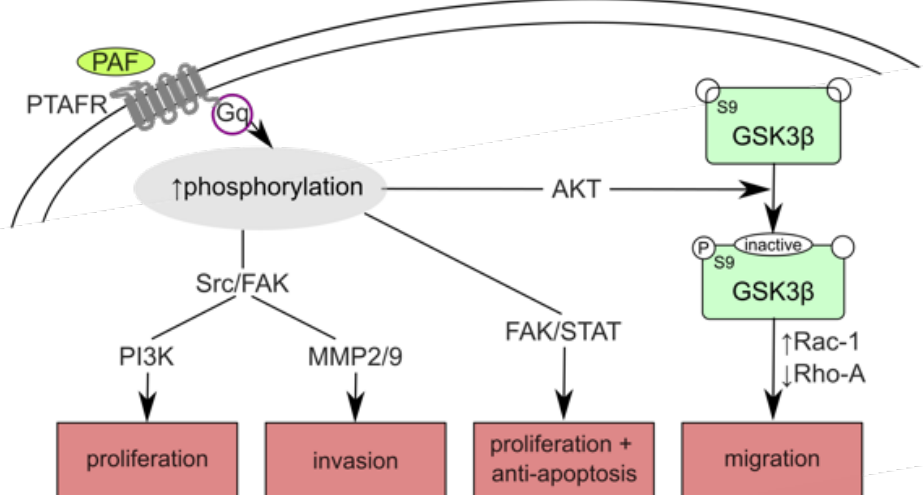
Figure 8. Functional consequences of PAF-AH silencing. By PLA2G7 silencing, PAF-mediated signaling dominated. Binding to its Gq-coupled receptor PTAFR, PAF activated phosphorylation cascades, which often lead to oncogenic transformation, tumor growth, angiogenesis, and metastasis [15,53,60,61]. Activation of Src/FAK and their downstream targets PI3K and MMP2/MMP9 resulted in cancer cell proliferation and cancer invasion, respectively [15]. Proliferation and anti-apoptosis are induced via FAK/STAT [61]. GSK-3 β is inactivated by AKT, leading to enhanced migration by Rac-1 activation and Rho-A inactivation and active Wnt signaling by stabilizing β -catenin [53].